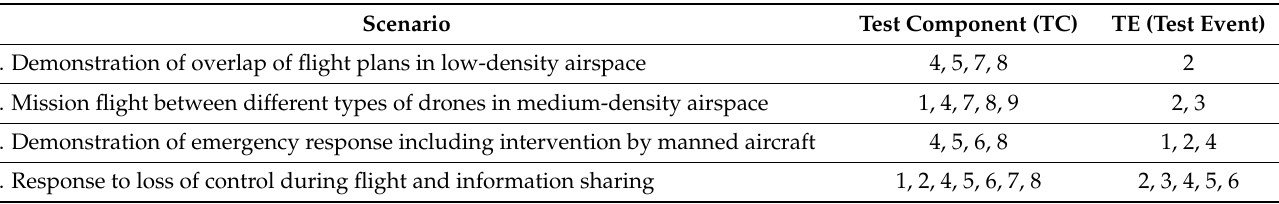
Table 4. Relevant TC and TE for each scenario.